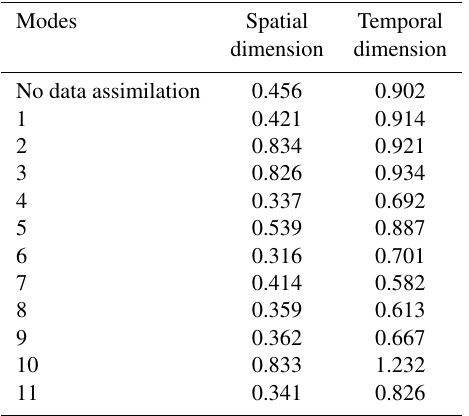
Table 4. RMSEs for the spatial and temporal distributions of the forecasted rainfall from different data assimilation